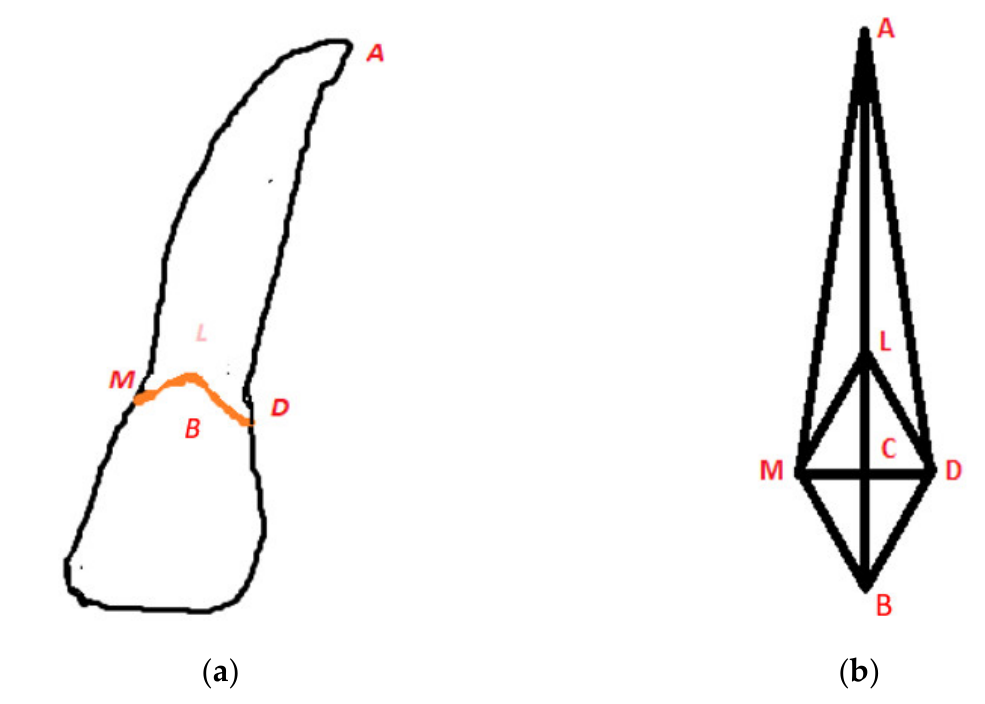
Figure 3. Dental root representation and geometric measurements: ( a ) assimilation to a polyhedric figure with a pyramidal shape as a base (i.e., the crown, delimited by the cement–enamel junction) and ( b ) a rhombus and a vertex that stands for dental apex. Legend: Natural tooth root midpoints: (A) Apex; (M) Mesial; (D) Distal; (B) Buccal. Tooth root replica geometric model: (A) Apex: (MD) Mesial-distal diagonal; (BL) Buccal-lingual diagonal; (C) Intersection point between mesial-distal and buccal-lingual diagonals.